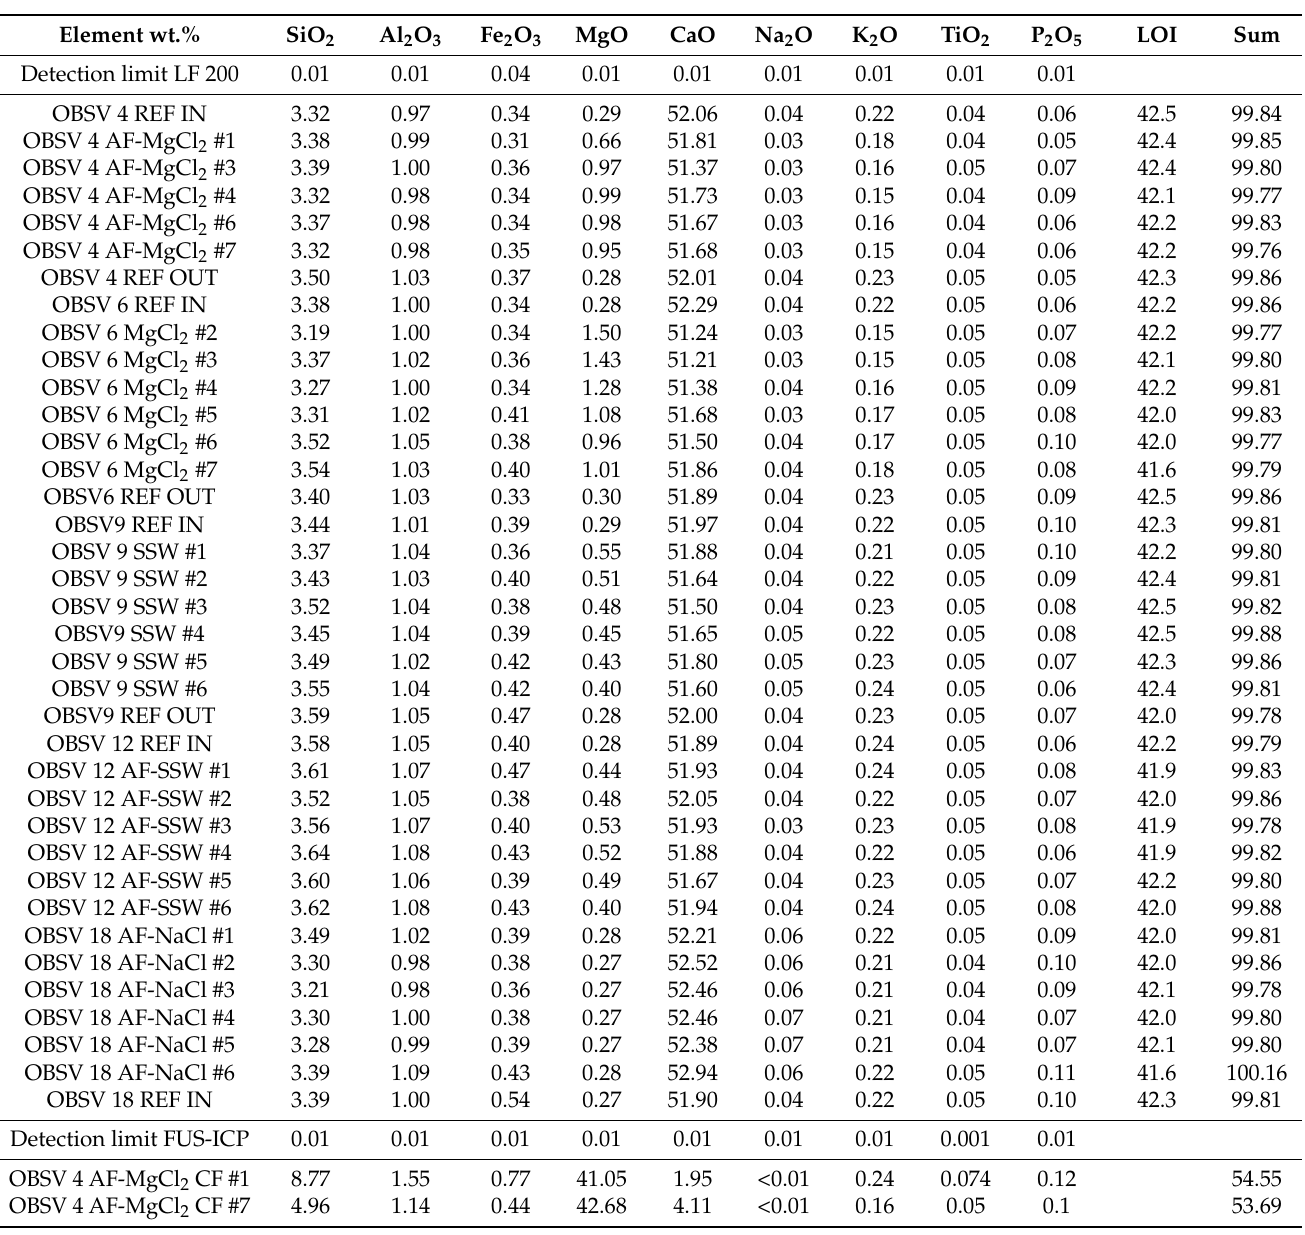
Table 3. Major element geochemistry for reference material, flooded samples, and central fill (CF) from OBSV 4 AF-MgCl 2